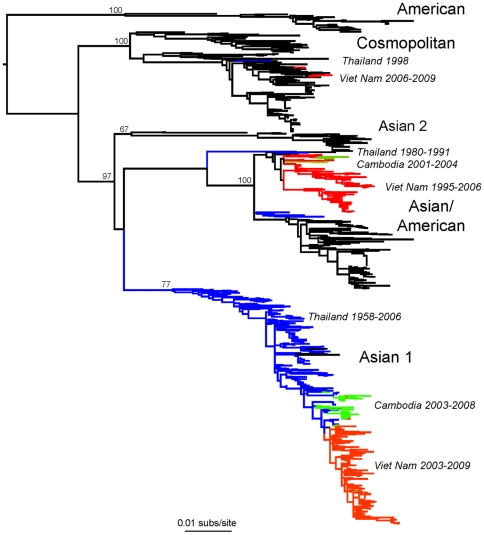
Maximum likelihood tree of 941 DENV-2 E gene sequences sampled globally.Viruses from Viet Nam are shaded red, those from Cambodia shaded green and those from Thailand shaded blue. The sampling years for Viet Nam, Cambodia and Thailand are annotated next to the tree. Bootstrap support values are shown at key nodes. The tree is mid-point rooted for purposes of clarity and all horizontal branch lengths are drawn to a scale of nucleotide substitutions per site.